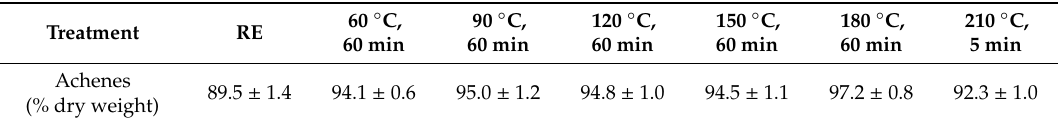
Table 5. Quantification of achenes present in untreated RE and in the different SPs obtained after each hydrothermal treatment (percentage of achenes in dry weight).